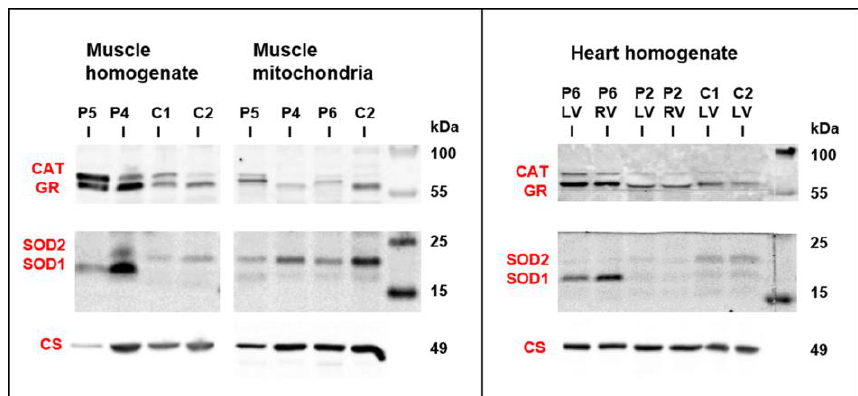
Figure 6. Western blot detection of antioxidative enzymes in skeletal muscle and heart. Both P4 and P5 muscle homogenates revealed variable increase in antioxidative enzymes glutathione reductase (GR), catalase (CAT), and superoxide dismutases 1 and 2 (SOD1, SOD2). Increased content of CAT, GR, and SOD1 was also found in heart ventricles of P6. Protein aliquots – muscle homogenate 30 µg, muscle mitochondria 15 µg, and heart homogenate 20 µg. For comparison, citrate synthase signal (CS) from Figure 5 is shown.